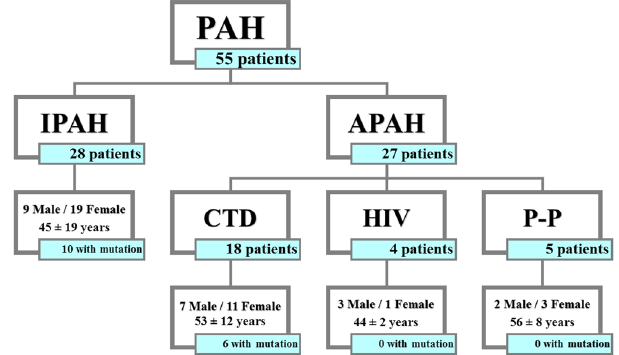
Figure 1. Diagram of the population under study. This figure shows the total number of patients included in this study (55 patients) classified according to PAH type (28 patients with IPAH and 27 patients with APAH), gender, mean age at diagnosis and pathogenic mutations in BMPR2 gene. PAH: Pulmonary Arterial Hypertension; IPAH: Idiopathic Pulmonary Arterial Hypertension; Associated Pulmonary Arterial Hypertension; CTD: Connective Tissue Disease; HIV: Human Immunodeficiency Virus; P-P: Porto-Pulmonary